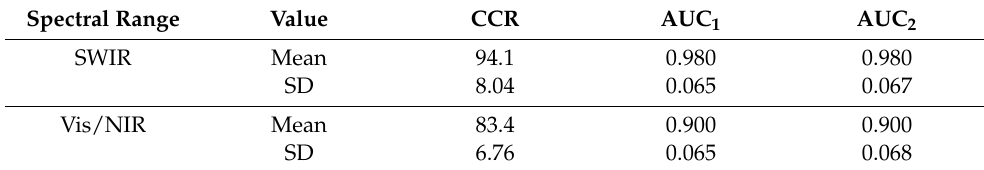
Table 4. Mean and standard deviation (SD) of the MV classifier for the 200 iterations, using the CCR and the AUCs (AUC 1 stands for the defective class, and AUC 2 for the healthy class), over the two spectral ranges .